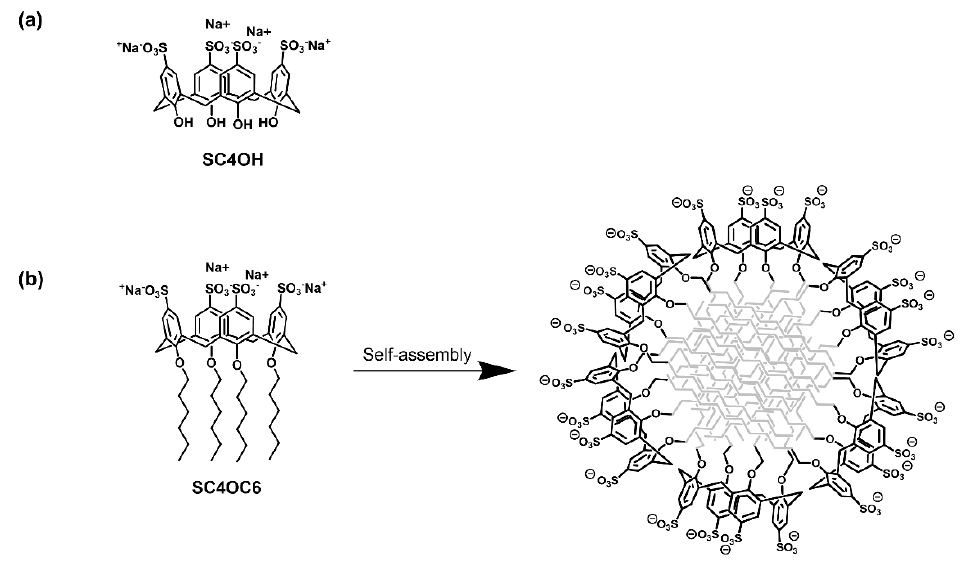
Figure 2. ( a ) Structure of the p -sulfonato-calix[4]arene-OH (SC4OH); ( b ) structure of the p -sulfonato-calix[4]arene- O -hexyl (SC4OC6); and schematic representation of its self-assembly in a micellar nanoaggregate.